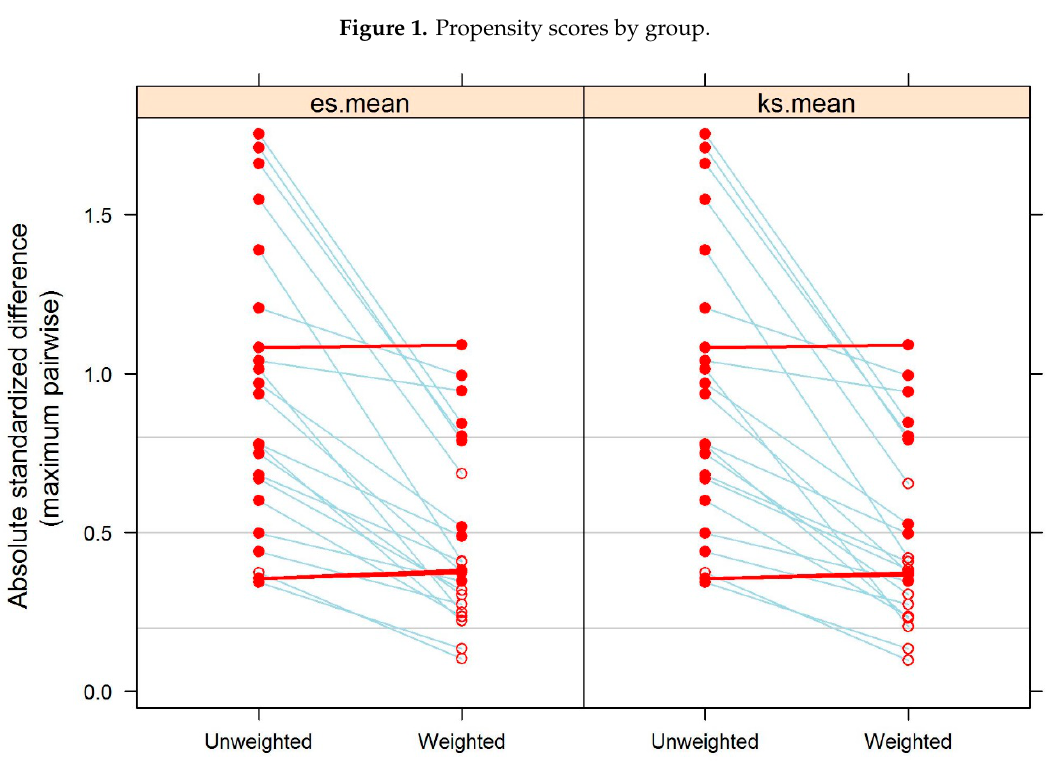
Figure 1. Propensity scores by group.